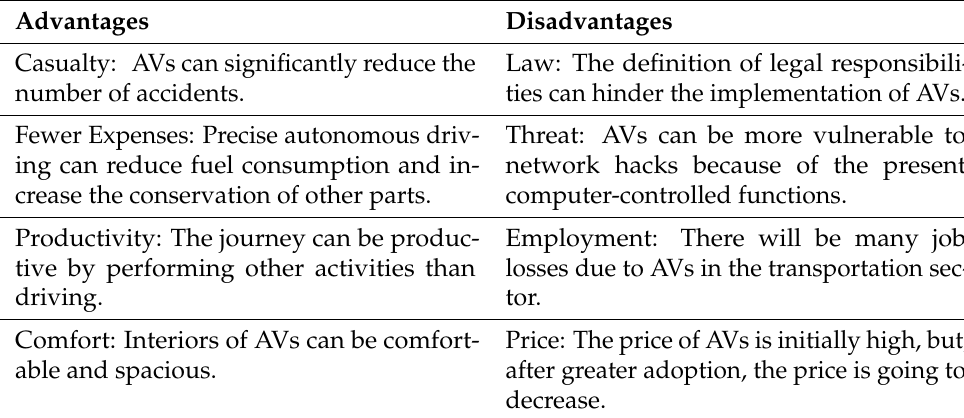
Table 2. Advantages and disadvantages of